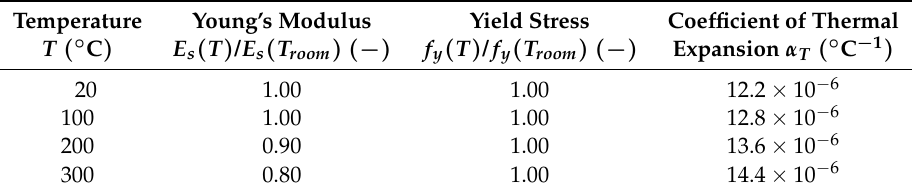
Table 7. Temperature-dependent thermoelastic properties of